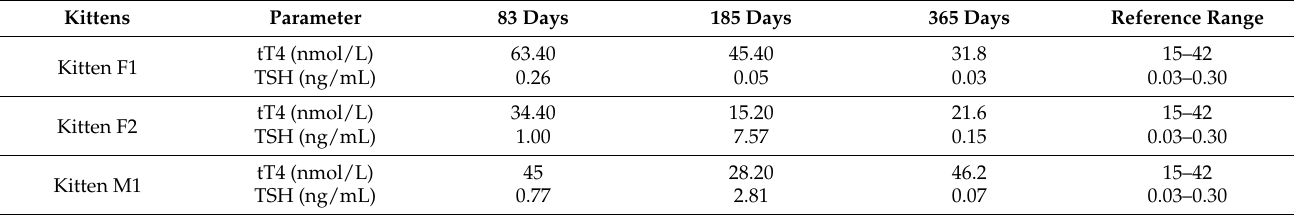
Table 3. Serum tT4 and TSH concentrations during the follow-up examinations.